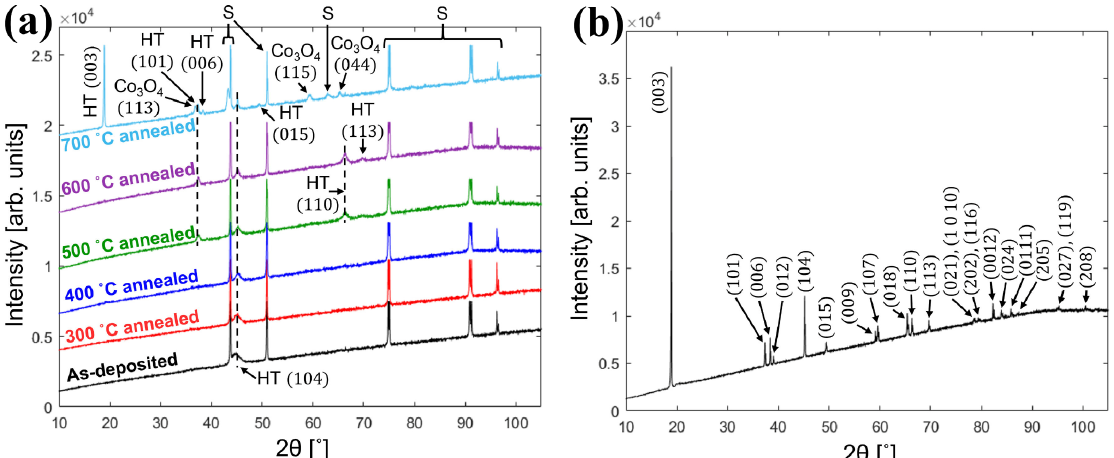
Figure 1. ( a ) XRD patterns of as-deposited and annealed LCO films at different temperatures. Peak labels of HT-LCO and substrates are abbreviated to HT and S, respectively. ( b ) XRD pattern of LCO powder from its LCO target. Reproduced with permission [46]. Copyright 2021, Elsevier.